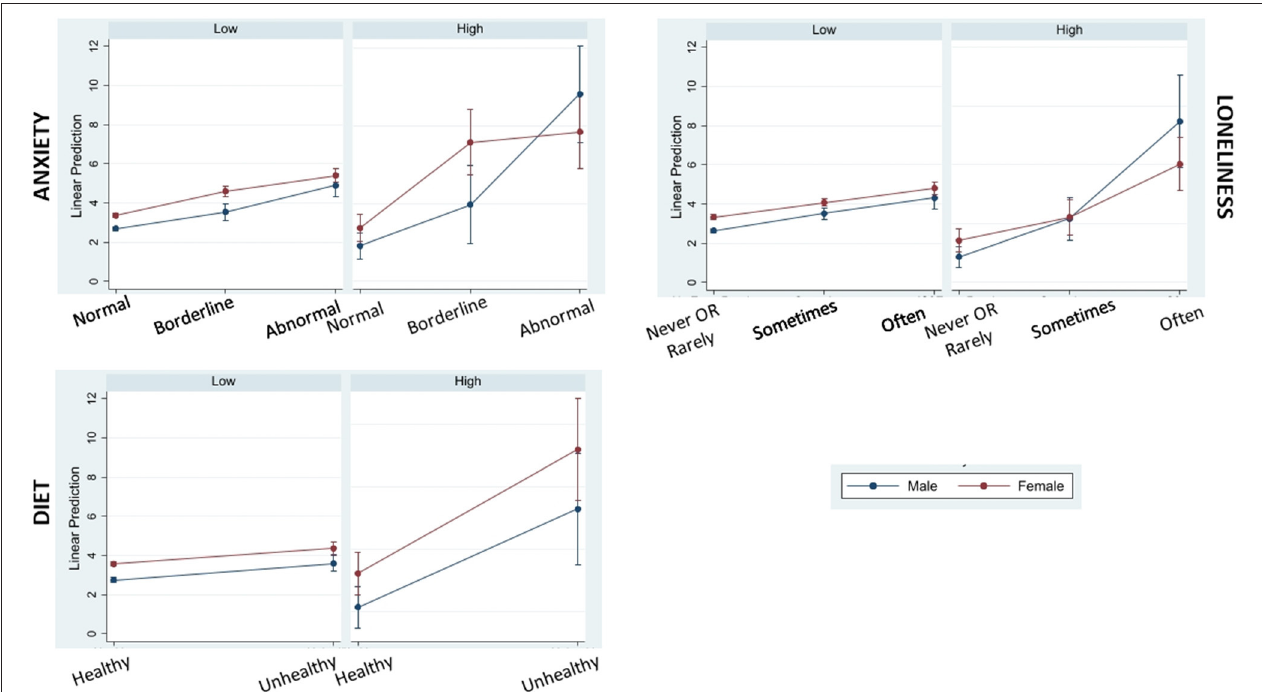
FIGURE 2 | Marginal plots showing interactions of COVID-19 complication risk level (low and high) with significant moderators of poor sleep quality during lockdown (anxiety, loneliness, and diet) by sex (male and female). Higher PSQI-CCRR (sleep scale) scores indicative of poor sleep quality are predicted for males in the Covid High risk category who scored highest in the anxiety component of HADS scale (Abnormal group) and who reported “Often” feeling lonely during the Covid-19 lockdown period. Conversely, higher scores representing poorer sleep quality are predicted for females in the Covid High risk category who had Unhealthy diets during the Covid-19 lockdown